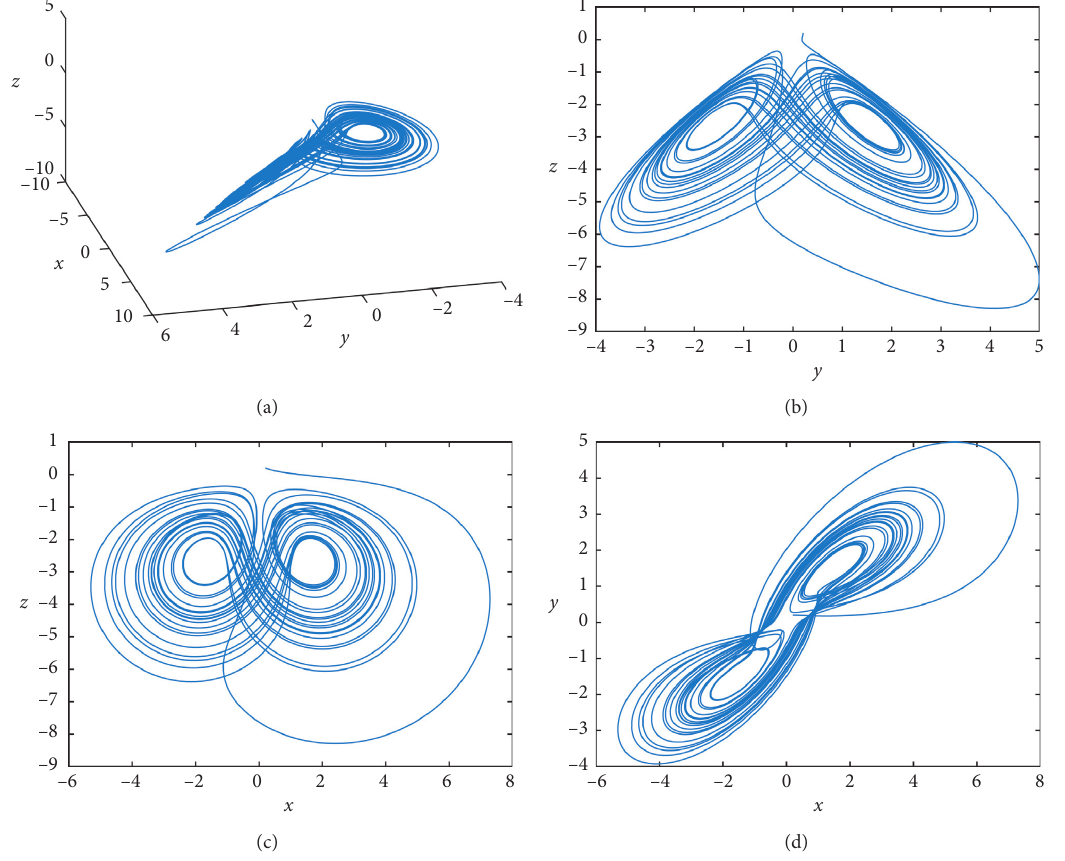
Figure 7: Phase portraits with the order α � 0 . 95 and a � 1 .